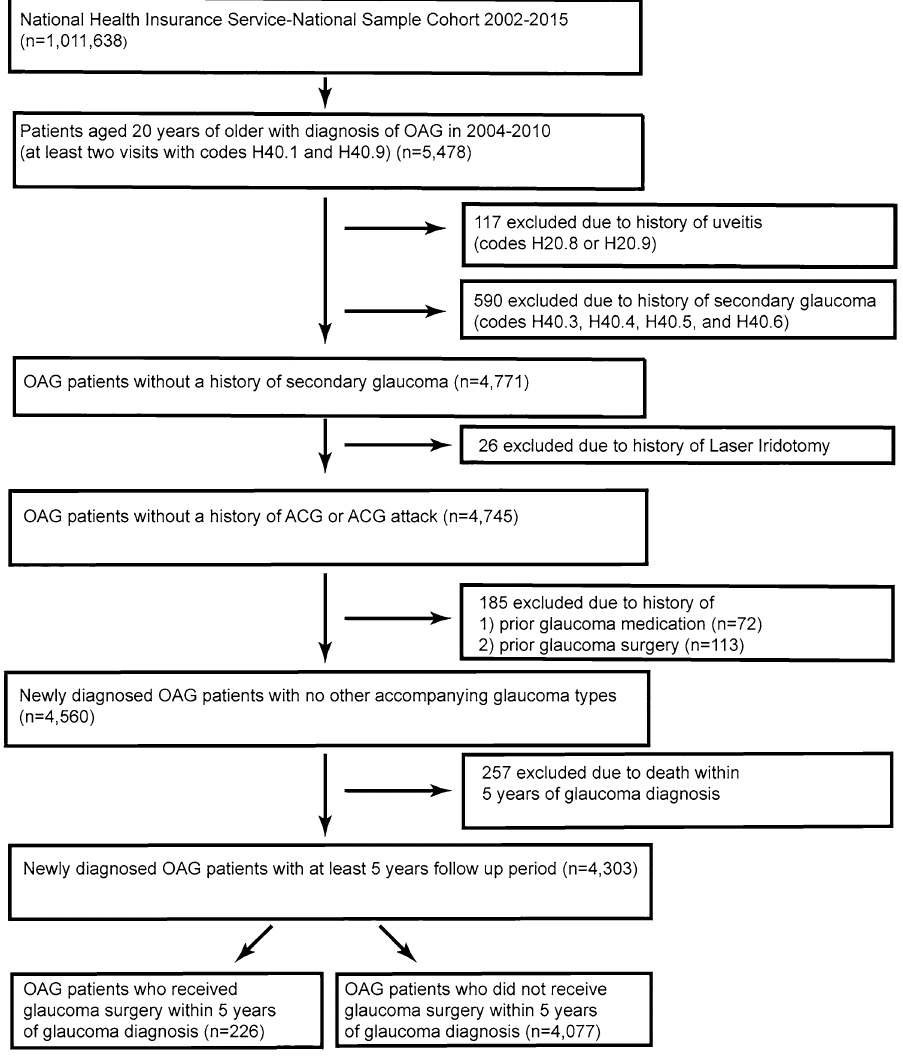
Figure 1. Flow diagram of study population selection. OAG: open-angle glaucoma, ACG: angle-closure